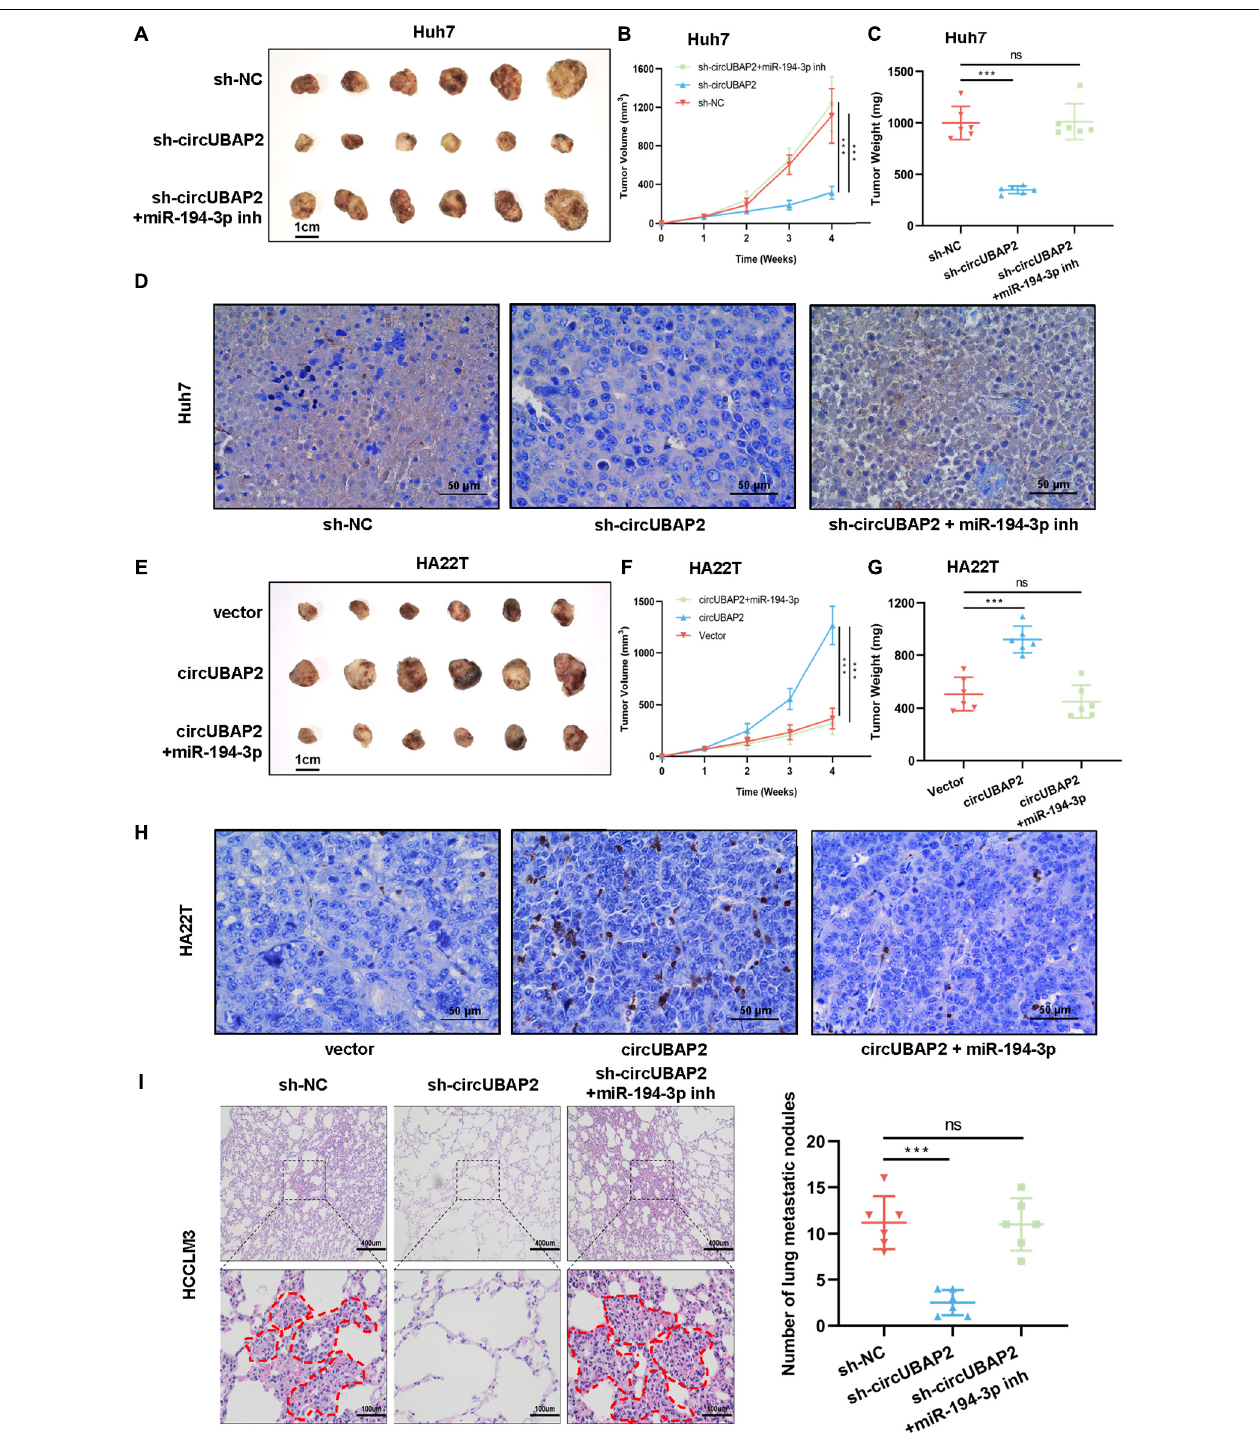
FIGURE 6 | CircUBAP2 promotes the progression of HCC in vivo . (A) Images of subcutaneous xenografts of sh-NC, sh-circUBAP2 and sh-circUBAP2 with miR-194-3p inhibitors Huh7 cells in nude mice ( n = 6). (B) The volume of subcutaneous xenografts induced by Huh7 cells in nude mice was recorded every week for 4 weeks ( n = 6). (C) The Huh7 tumor weights were calculated after removing the tumors ( n = 6). (D) Immunohistochemical detection of MMP9 expression in Huh7-derived tumor tissues (E) Images of subcutaneous xenografts of oe-vector, oe-circUBAP2 and oe-circUBAP2 with miR-194-3p mimics HA22T cells in nude mice ( n = 6). (F) The volume of subcutaneous xenografts induced by HA22T cells in nude mice was recorded every week for 4 weeks ( n = 6). (G) The HA22T tumor weights were calculated after removing the tumors ( n = 6). (H) Immunohistochemical detection of MMP9 expression in HA22T-derived tumor tissues (I). HE staining and number of the HCCLM3-derived lung metastatic nodules at the endpoint ( n = 6). ns means P > 0.05 and *** P > 0.001.